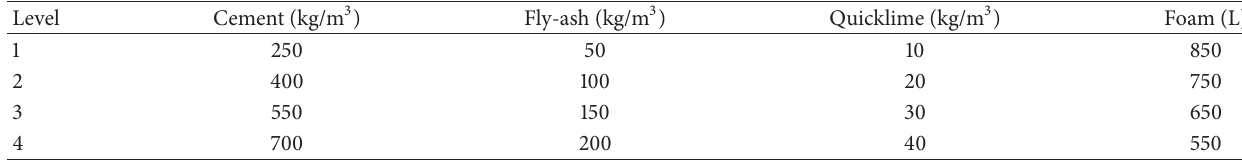
Table 1: Four levels of each affecting factor.